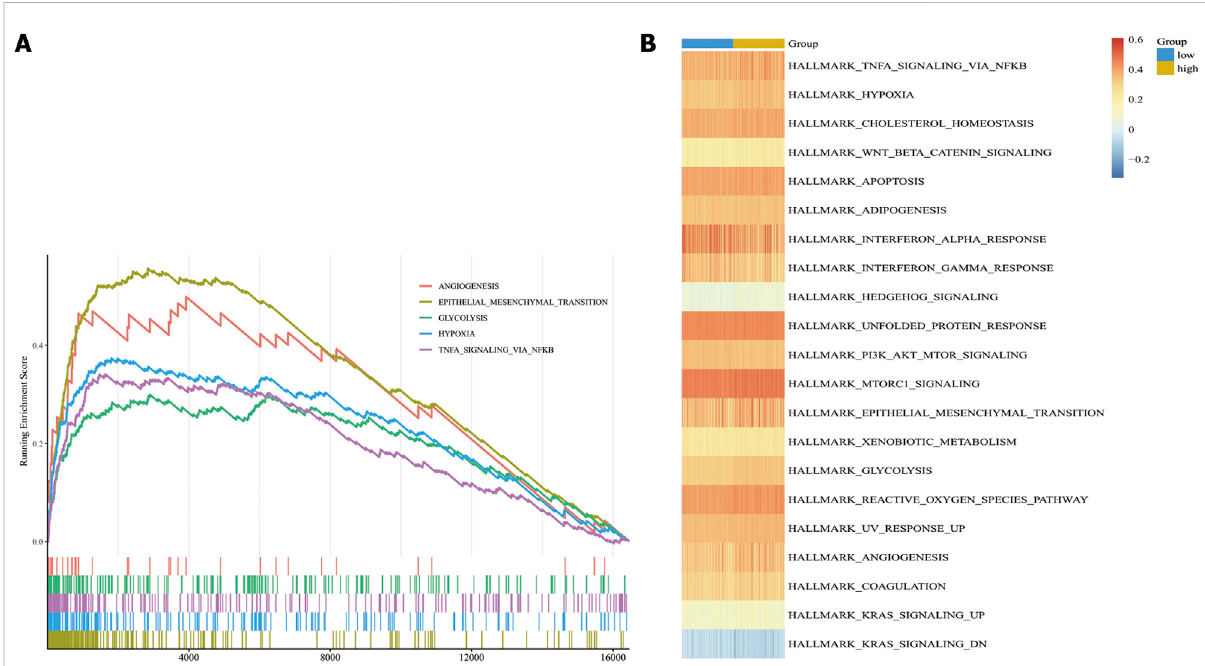
FIGURE 5 Molecular characteristics in CAF-high group and CAF-low group in TCGA-HNSC cohorts. (A) , Top4 tumor-associated gene sets enriched in CAF-high subgroup (FDR q-val < 0.01). (B) , Heatmap of gene sets correlated signi fi cantly with CAF signature ( p < 0.05). (C,D) , Waterfall plot illustrated the Top10 mutated genes in the TCGA-HNSC cohort patients in CAF-high groups (C) and CAF-low group (D) . Samples (central columns) are arrangedtoemphasizemutualexclusivityamongmutations.Theupperplotshowsthemutationfrequencyofeachpatient.Therightplotshows mutation percentage, the color coding in the bottom indicates the mutation types. (E,F) , Detailed information of top 10 genes with different copy number variation in CAF-high subgroups (E) and CAF-low group (F) (p-value of all genes are less than 0.0001). Samples (columns) in the central are arranged to emphasize copy number variated among patients. Each column in the upper represents a patient, the left percentages show the proportion of patients with mutated gene and the barplots in the right indicate the alteration